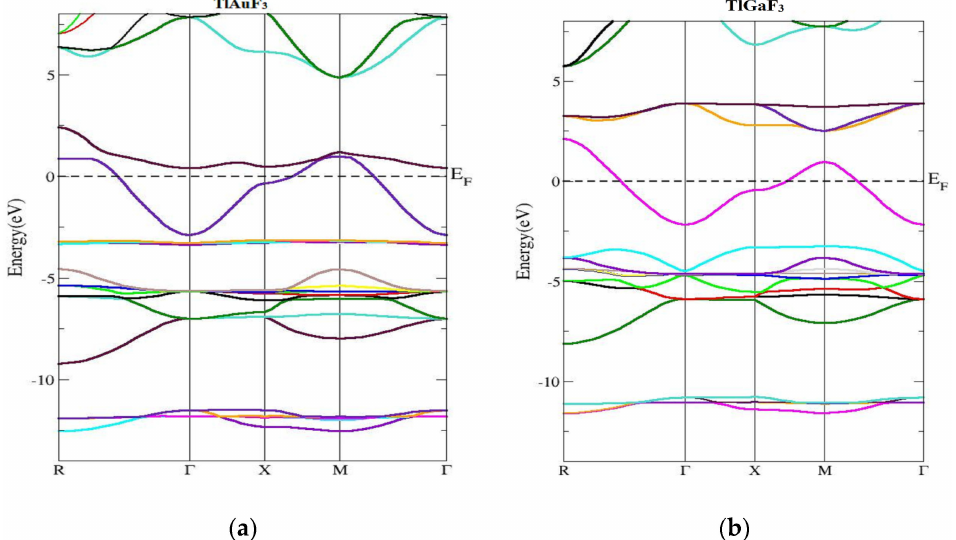
Figure 3. Computed band structures of TlMF 3 (M= Au, Ga). ( a ) Represent band structure of TlAuF 3 ( b ) Represent band structure of TlGaF 3